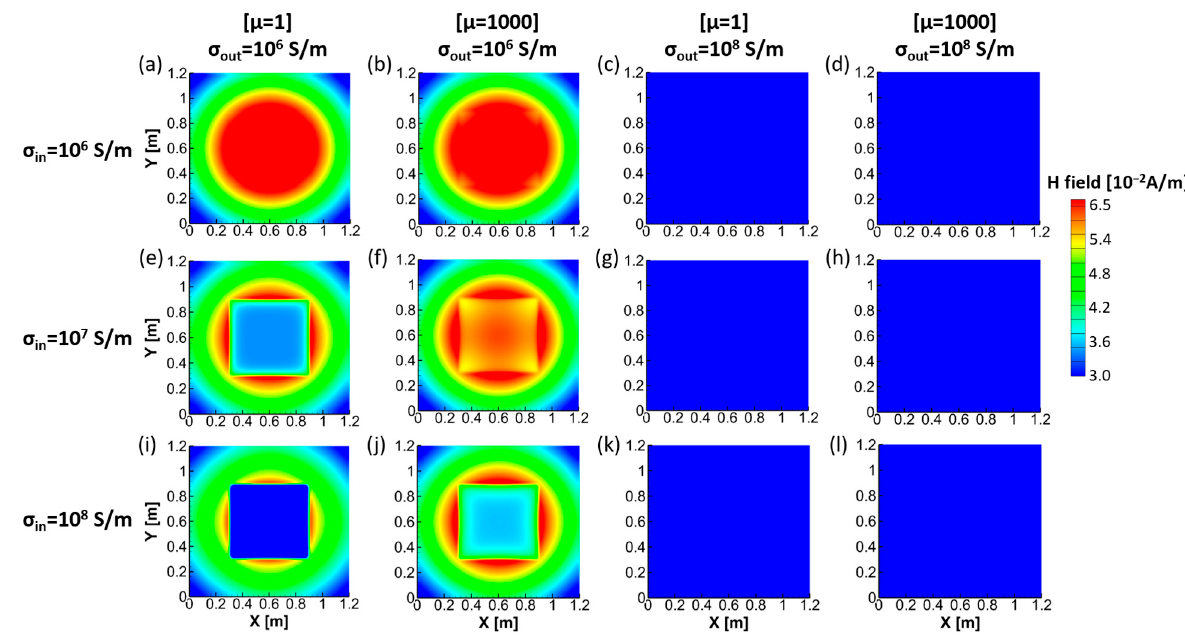
Figure 7. H fields on xy plane at z = − 0.005 m for ( a , c , e , g , i , k ) conductive ( µ r = 1) material and ( b , d , f , h , j , l ) ferromagnetic ( µ r = 1000) material through an outer shell at 50 Hz signal. The conductivities of the outer shell and inside box are in the range of 10 6 to 10 8 S/m. The inside object in cube geometry has lengths 0.6 with the center and the outer shell has 2.7 mm thickness.